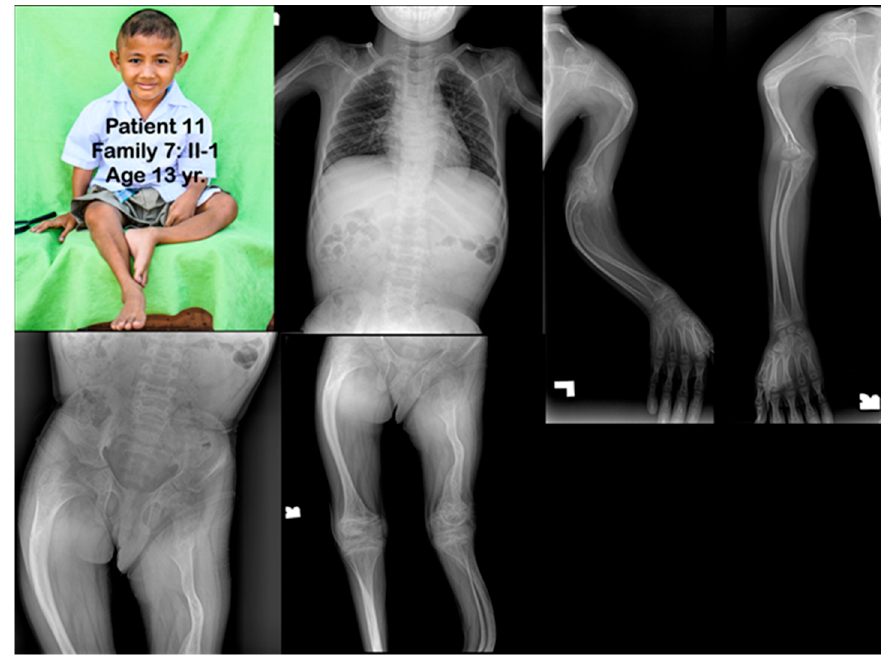
Figure 7. Family 7. Patient 11 (Family 7: II-1). Age 13 years. Generalized severe osteopenia. All long bones are severely slender and bowed. Humeri and femora are shortened. Fractures of clavicles are noted. Multiple fractures of long bones are healed. Metaphyseal flare of distal femora, proximal tibiae, proximal humeri, and distal humeri are noted. Popcorn calcifications are not observed.